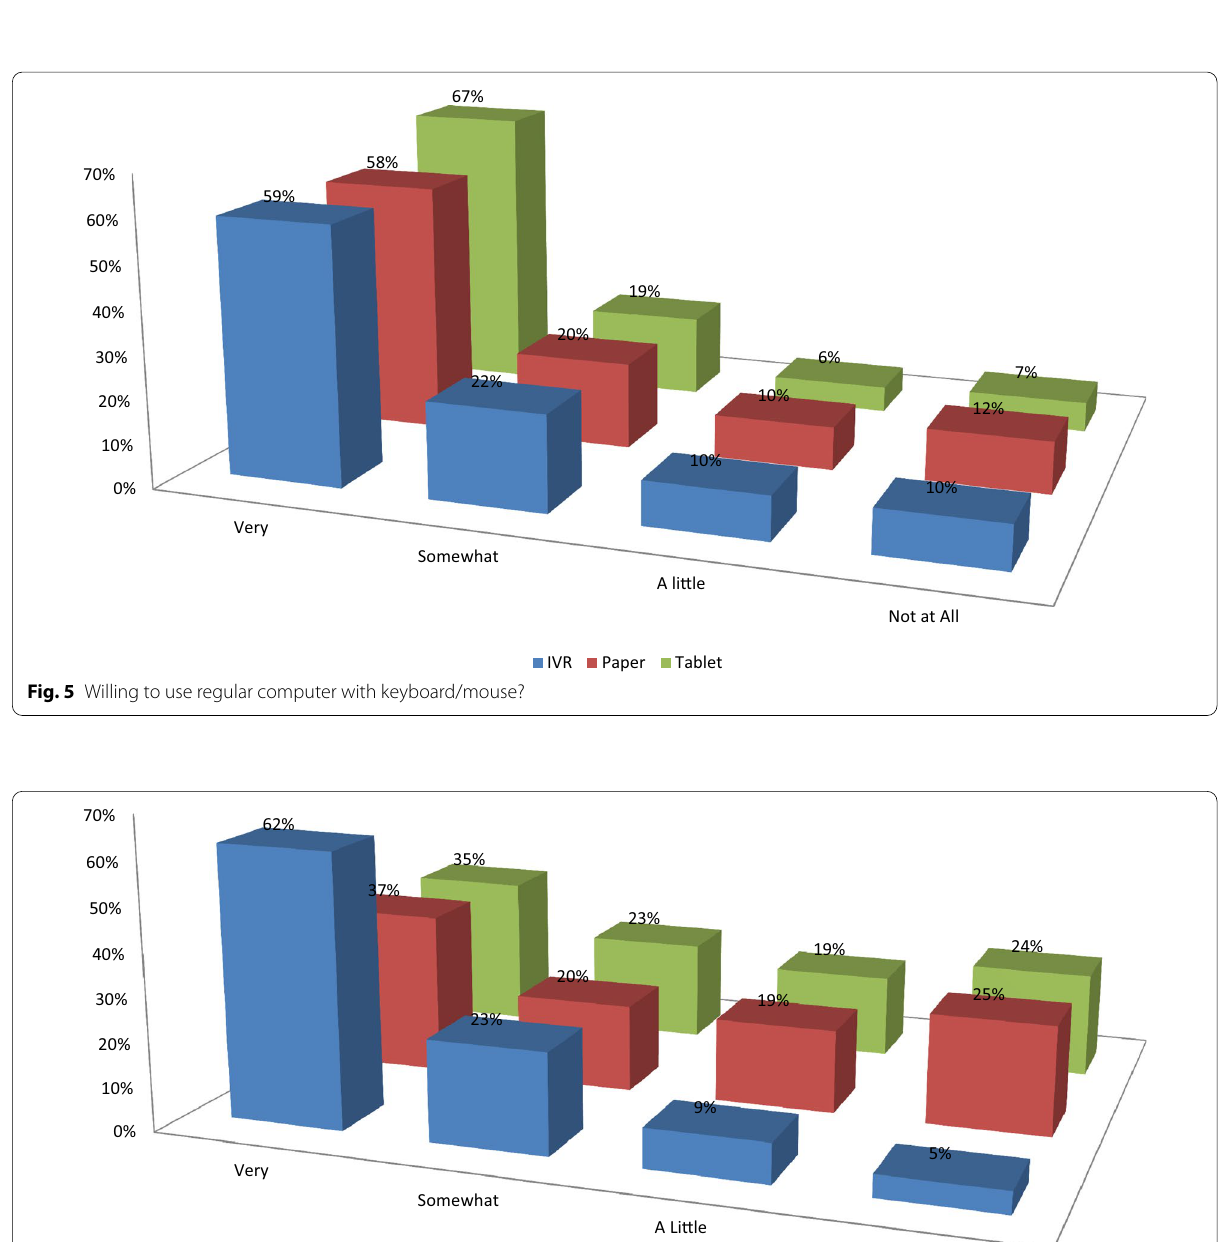
Lastly, patients who were randomized to IVR were most likely to respond that they were very willing to use IVR (62% compared to 37% for PSAQ and 35% for CSAQ; Fig. 6). In general, the use of a specific mode positively influenced future receptiveness to that mode.